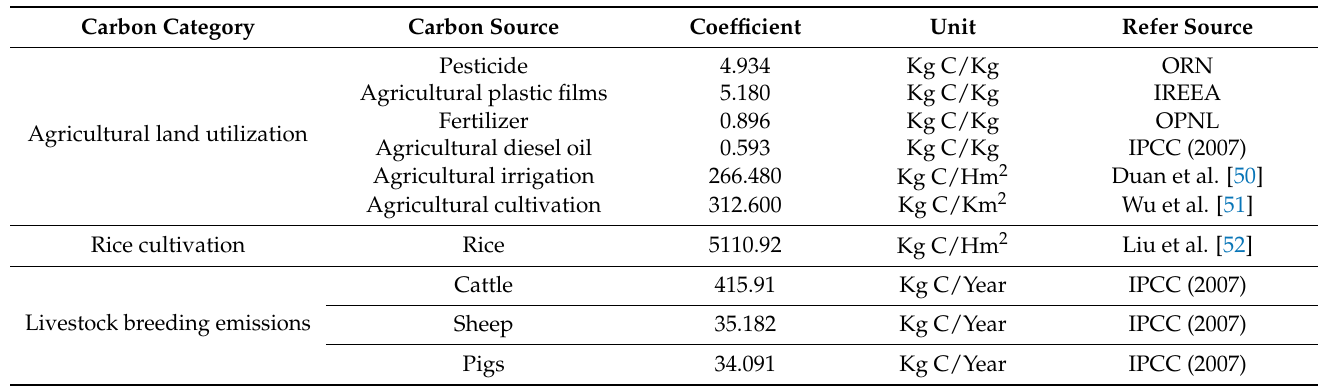
Table 2. ACEs sources and corresponding carbon emission